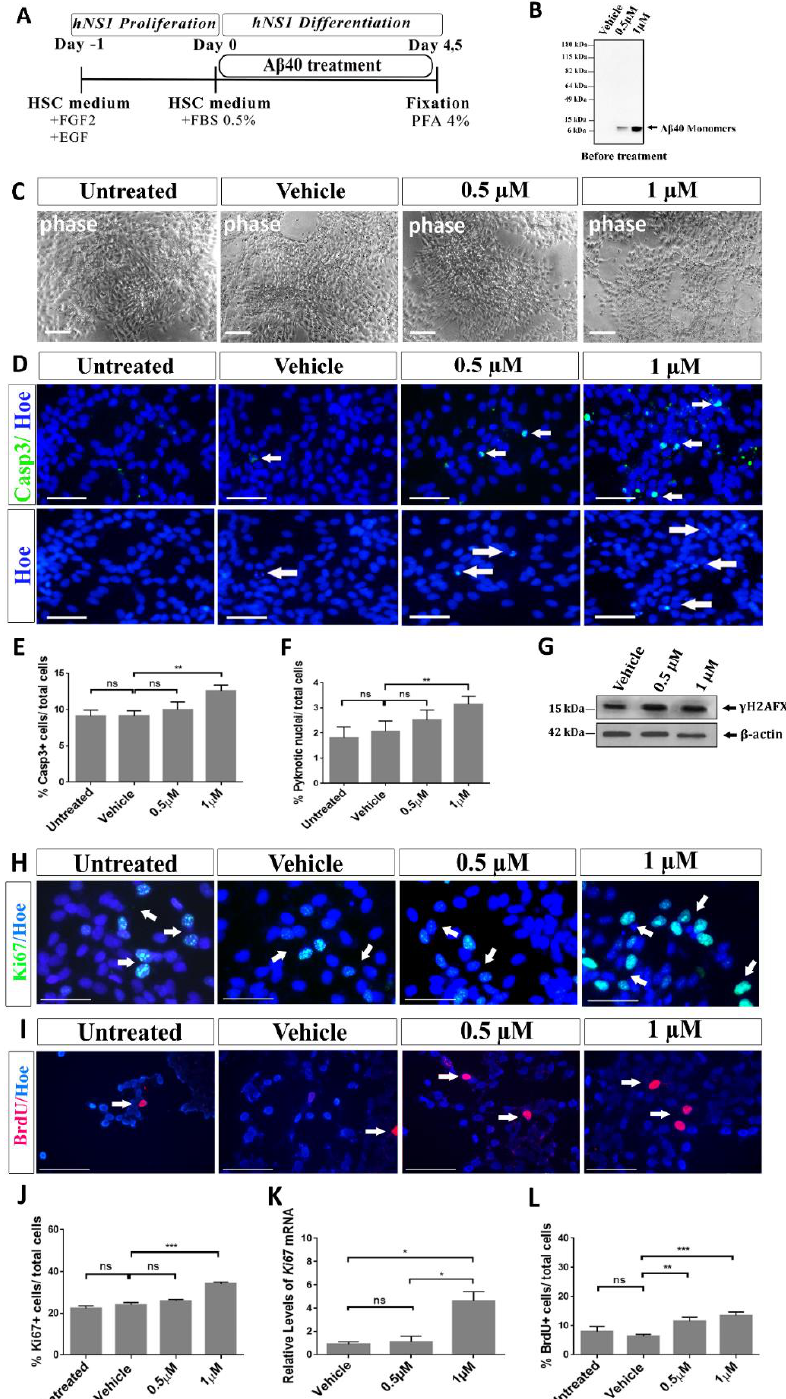
Figure 1. A β 40 enhances cell death and promotes proliferation in differentiating hNS1 cells. ( A ) Schematic view of the hNS1 differentiation protocol (see the Materials and methods section). ( B ) Representative Western blot (WB; using 4G8 antibody) analysis of the A β 40 forms at different concentrations (0.5 and 1 µ M) present in the extracellular medium before the treatment with the A β 40 peptide. ( C ) Representative phase contrast images of hNS1 cells treated with the different doses (0.5 µ M and 1 µ M) of the A β 40 peptide and control groups (untreated and vehicle (DMSO) treated cells) for 4.5 days. ( D ) Representative images of activated caspase-3 immunoreactivity (upper panels; ActCasp3; green, see arrows). Representative images of fragmented nuclei stained with Hoechst (lower panels; Hoe; see arrows). Scale bars, 100 µ m ( C ) and 50 µ m ( D ). ( E ) Analysis of the